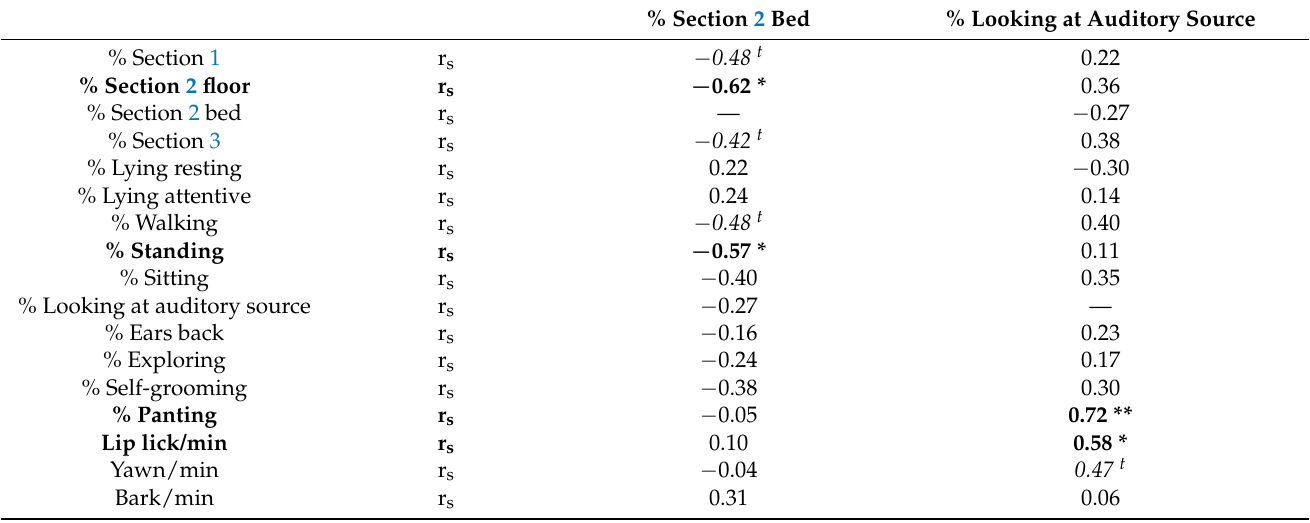
Table 5. Spearman rank correlations between “% Section 2 bed” and “% Looking at auditory source” and all other behaviours recorded in dogs during the P+ condition only ( N = 14). Significant correlations are depicted in bold, tendencies in italics.